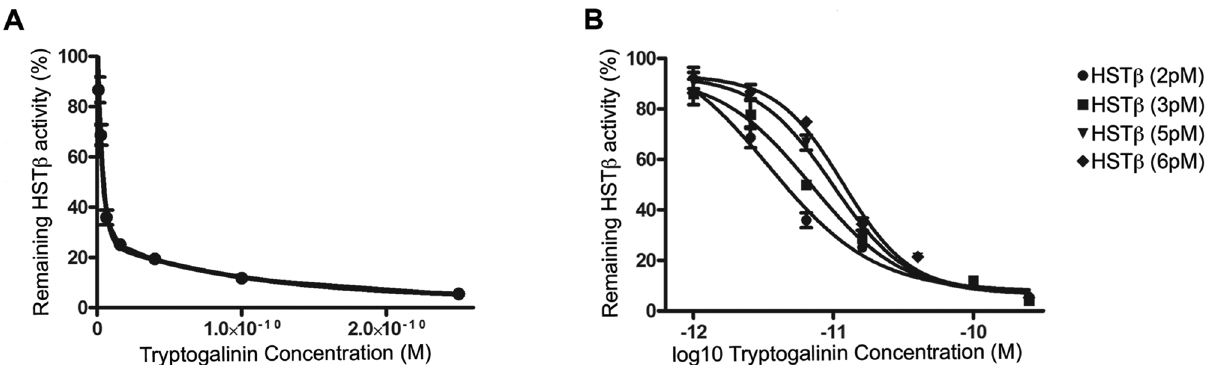
Figure 3. A–B. Inhibition of HST b by tryptogalinin. A two-phase exponential fit of the data for HST b inhibition suggests a 2:1 binding ratio (A) for tryptogalinin and HST b (2 pM). Tryptogalinin tightly binds to HST b (B) – as the enzyme increases so does the IC50 .